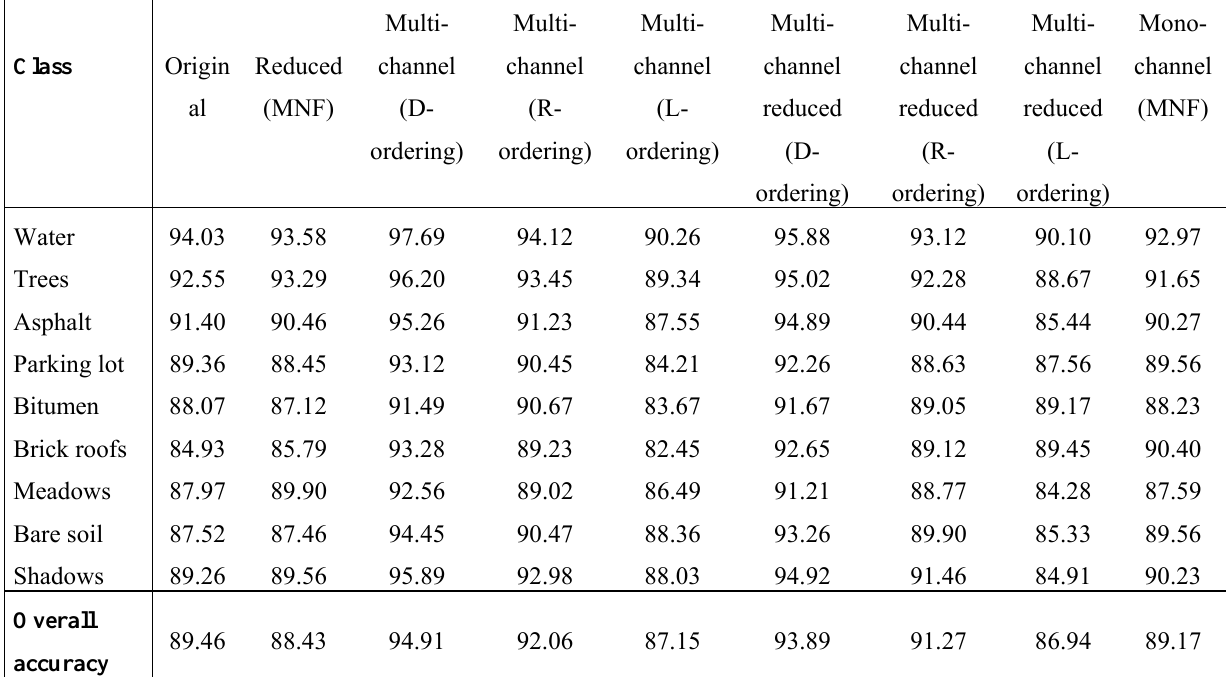
Table 3. Overall and individual test classification accuracies (in percentage) obtained after applying the proposed SVM classification system (with Gaussian kernel), using mono- channel and multi-channel morphological profiles with 10  k opening/closing operations, to the DAIS 7915 scene over the city of Pavia with 40 spectral bands. Results using the original spectral information and an MNF-based reduced version of the original scene (obtained after retaining the first 15  p components) are also displayed.